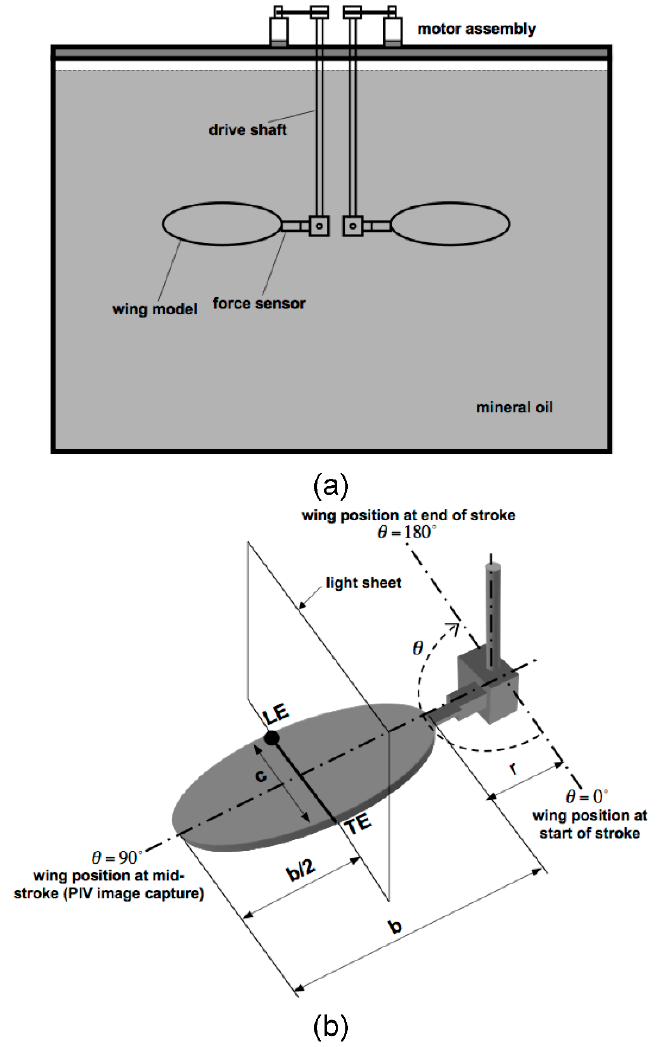
Figure 1. The experimental setup. ( a ) The dynamically scaled wing was immersed in a clear 1 m × 1 m × 2 m plexiglass tank filled with mineral oil. Only a single wing was used in this study; ( b ) The wing was constructed from 2.0 mm thick clear acrylic sheet ( c = 8.25 cm, b = 16.5 cm, and R = 20.1 cm) and revolved through a 180° arc in a horizontal stroke plane with constant angular velocity at a fixed angle of attack. Flow structure was visualized using two-dimensional digital particle image velocimetry (DPIV). The DPIV laser light sheet was oriented along the center of the wingspan. The Reynolds number was calculated as